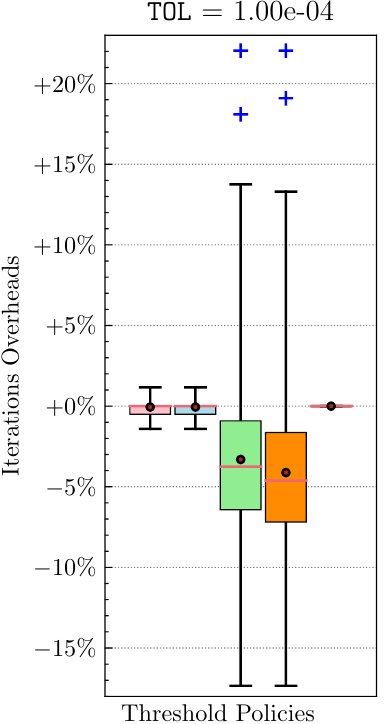
Figure 13. Total number of iterations’ overhead w.r.t each policy for TOL = 10 − 4 .